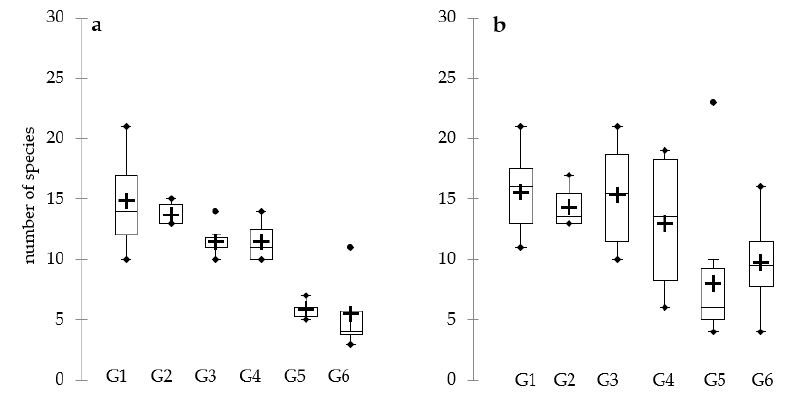
Figure 3. The number of Crustacea ( a ) and Rotifera ( b ) species in lakes with different oxygen conditions. The average biomass of zooplankton in harmonic lakes was 2.3 ± 2.1 mg L − 1 . The lakes from groups G2–G4 were characterized by a high biomass of zooplankton in the epilimnion and metalimnion, but a low biomass in the hypolimnion. The lakes from G1 were characterized by similar levels of zooplankton biomass in all three layers (Figure 4). The average biomass of zooplankton in dystrophic lakes was 2.7 ± 7.7 mg L − 1 . The high variability in zooplankton biomass in dystrophic lakes was due to Asplanchna priodonta in two lakes, with biomass reaching 40 mg L − 1 (lake no. 31, metalimnion). The low biomass of zooplankton in humic lakes was observed in the hypolimnion of G5 and metalimnion of G6 (Figure 4). The dominant group of zooplankton in harmonic lakes was large Cladocera, except the hypolimnion of G4 lakes, where large Cladocera were almost absent (Figure 4). The large Cladocera in the epilimnion of lakes from G1, G2, and G3 were strongly dominated by Daphnia cucullata and Diaphanosoma brachyurum , but Daphnia cristata and Daphnia longispina increased in the lower layers. The lakes from G2 and G4 were distinguished by a higher relative abundance of Rotifera, and the G4 lakes had an increased share of small Cladocera with a declining share of large Cladocera. The dystrophic lakes were characterized by Rotifera and small Cladocera, and by the low relative abundance of large Cladocera (Figure 4). The most common